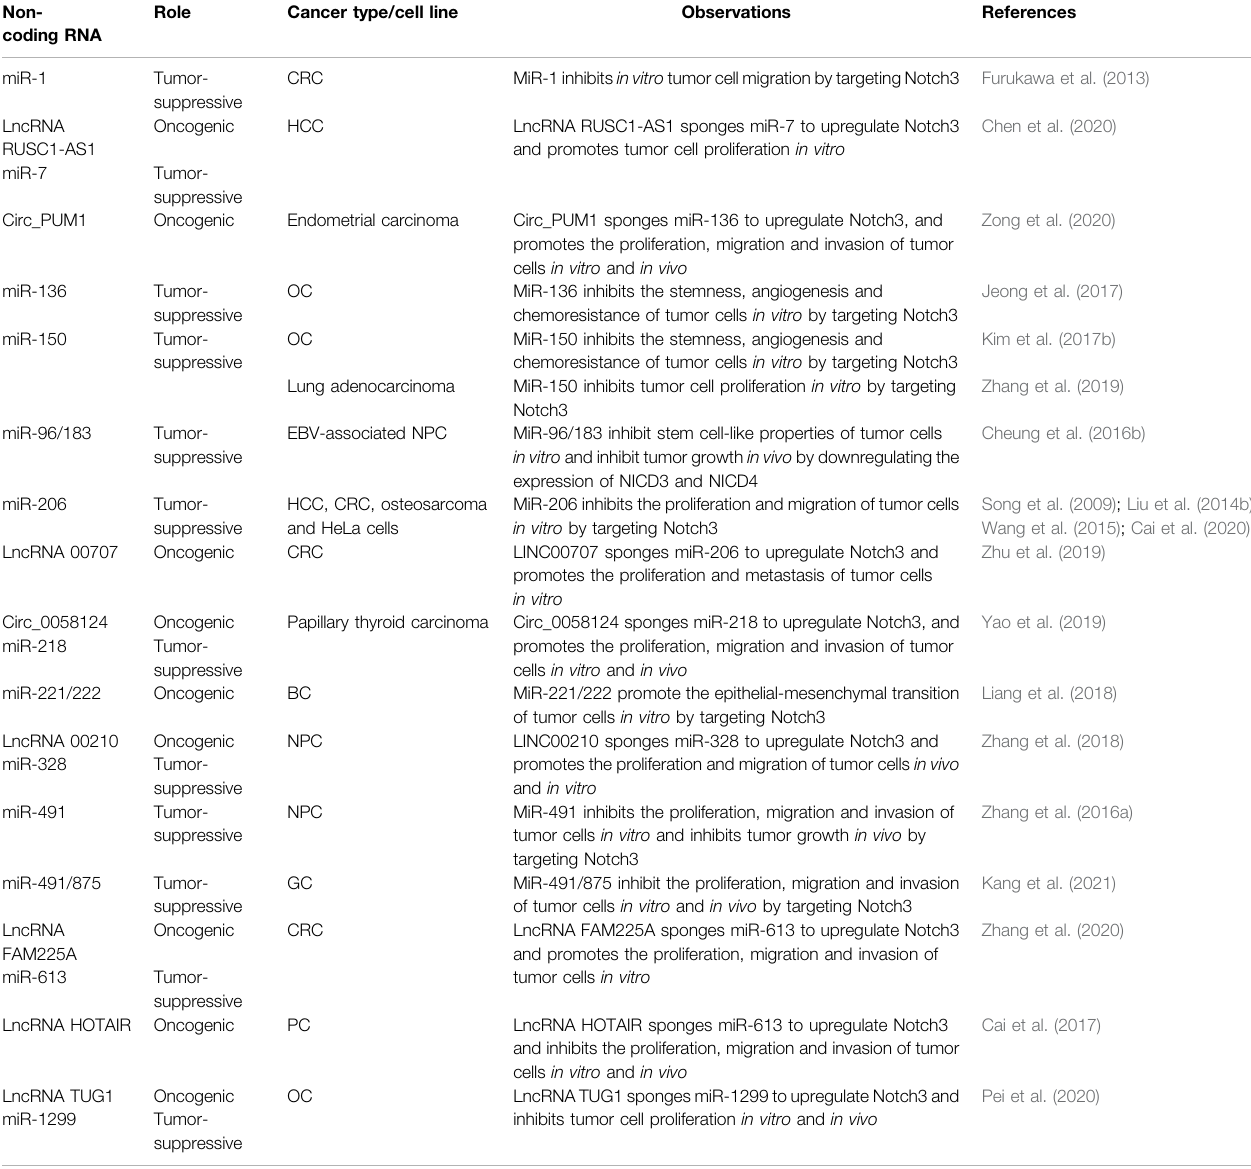
TABLE 2 | Non-coding RNAs that target Notch3 in